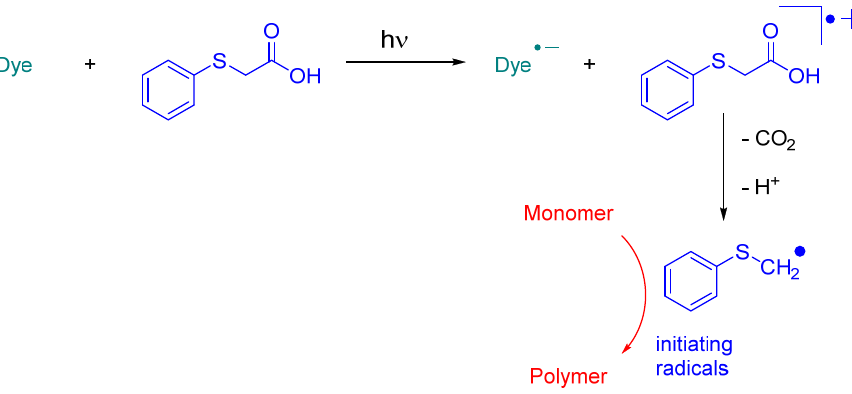
Scheme 2. Mechanism of photoinitiation with dye/phenylthioacetic acid system.